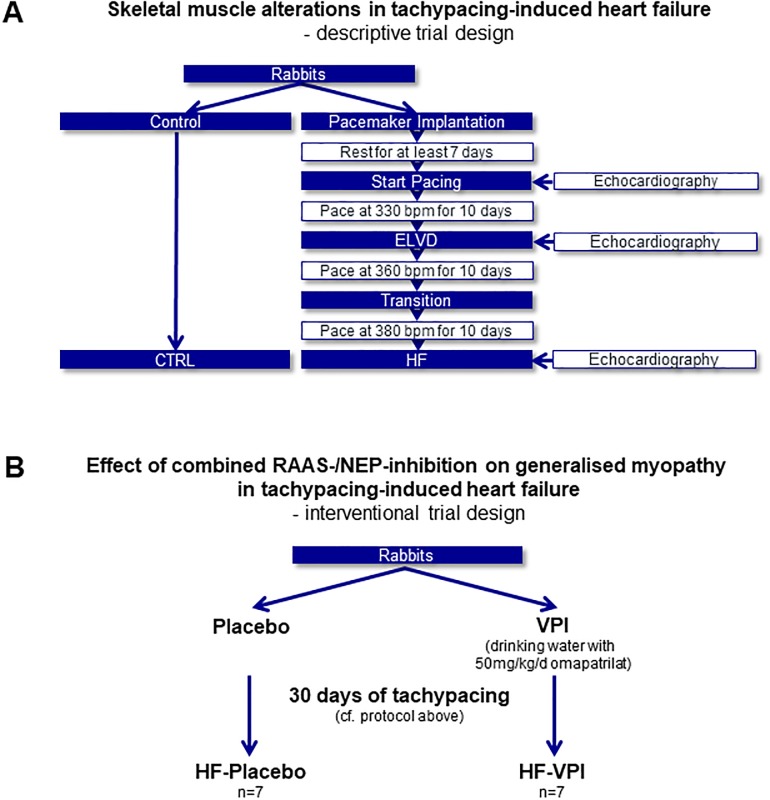
Sequential animal trial designs for first descriptive analyses and the subsequent pharmacological intervention study.(A) In a tachypacing-induced heart failure model, skeletal muscle alterations were analysed by histology and a multi-omics approach. The results generated the hypothesis, that combined RAS-NEP-inhibition could exert a potential beneficial effect on myopathy in heart failure. To scrutinise the hypothesis, a pharmacological interventional study was designed and performed (B). bpm: beats per minute. CTRL: control. ELVD: early left ventricular dysfunction. HF: heart failure. RAS-NEP-inhibition: combined inhibition of the renin-angiotensin system and neprilysin. VPI: vasopeptidase inhibitor omapatrilat, combined RAS/NEP-inhibitor.